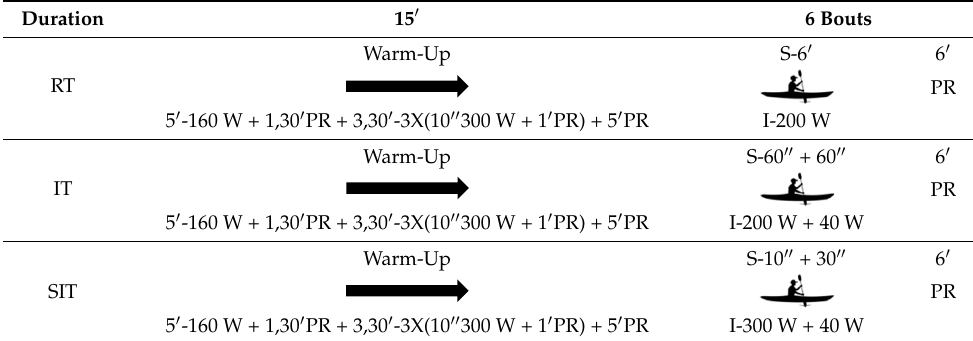
Table 2. Experimental conditions of the protocol depicting the three IT intensity modes.